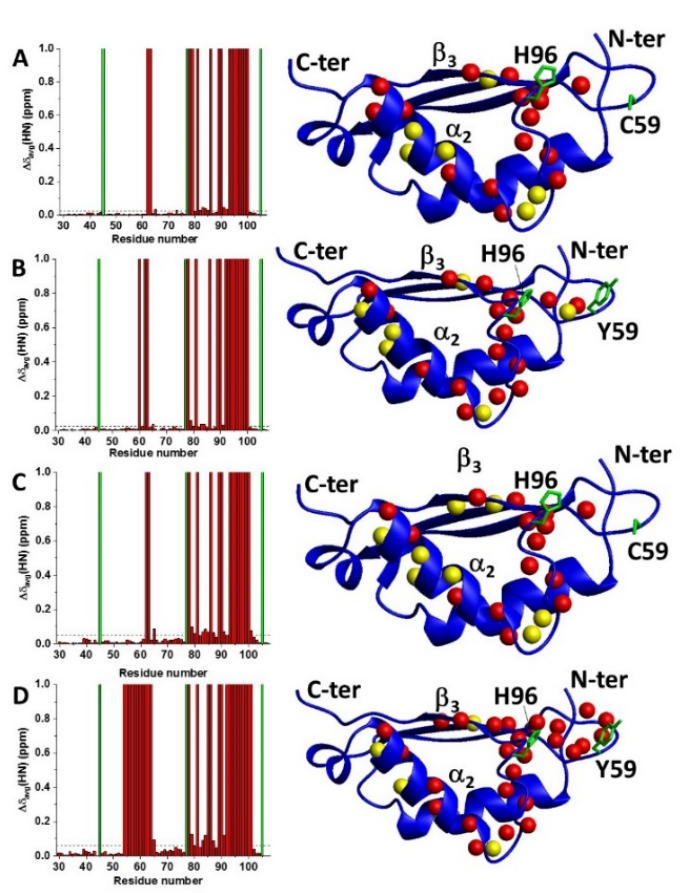
Figure 3. C59Y mutation promoted the formation of an aberrant protein–protein interaction. ( A ) Backbone weighted average chemical shift differences ( ∆ δ avg (HN)) on 15 N-labelled BOLA3 (100 µ M starting protein concentration) upon hetero-complex formation with apo GLRX5 (left panel). Meaningful chemical shift differences are mapped on the solution structure of BOLA3 (PDB 2NCL) (right panel). ( B ) ∆ δ avg (HN) on 15 N-labelled C59Y BOLA3 (100 µ M starting protein concentration) upon hetero-complex formation with apo GLRX5 (left panel). Meaningful chemical shift differences are mapped on the structural model of C59Y BOLA3 (right panel). ( C ) ∆ δ avg (HN) on 15 N-labelled BOLA3 (800 µ M starting protein concentration) upon hetero-complex formation with apo GLRX5 (left panel). Meaningful chemical shift differences are mapped on the solution structure of BOLA3 (PDB 2NCL) (right panel). ( D ) ∆ δ avg (HN) on 15 N-labelled C59Y BOLA3 (800 µ M starting protein concentration) upon hetero-complex formation with apo GLRX5 (left panel). Meaningful chemical shift differences are mapped on the structural model of C59Y BOLA3 (right panel). Red bars with ∆ δ avg (HN) = 1 indicate residues whose backbone NH signals broaden beyond detection. The green bars indicate proline residues or unassigned NHs. Chemical shift threshold values (see the Materials and Methods section) are indicated as dashed lines. On the blue ribbon diagrams, backbone NHs showing line broadening beyond detection are depicted as red spheres, while backbone NHs with chemical shifts above the thresholds are depicted as yellow spheres. Sidechains of Cys59, Tyr59, and His96 are shown as green sticks.